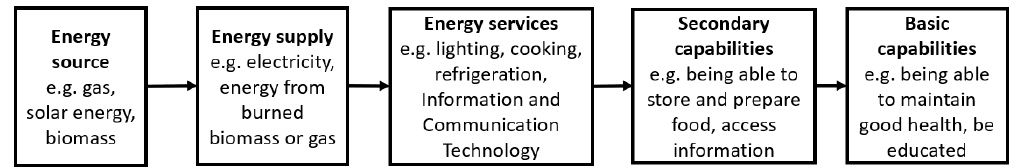
Figure 1. Relationship between energy and capabilities